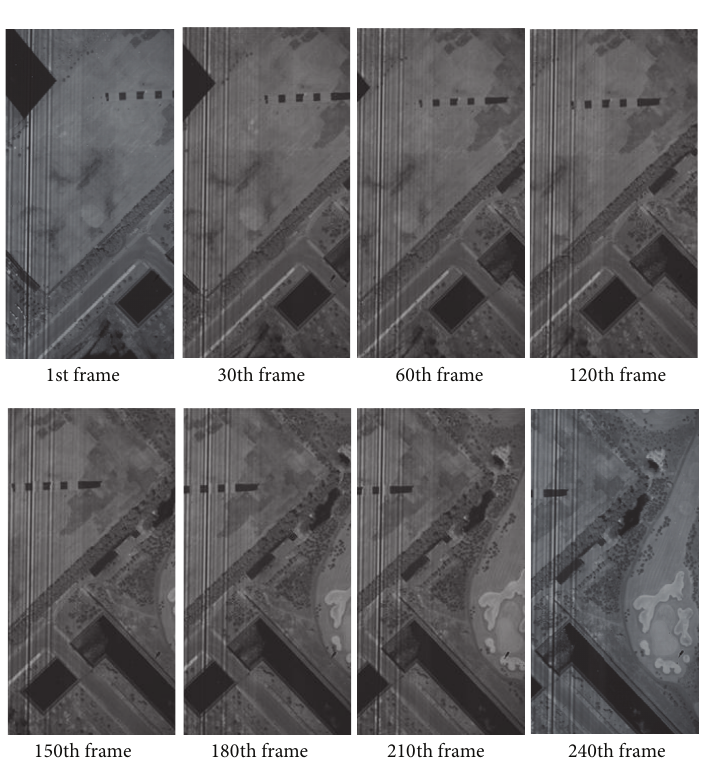
Figure 10: The interferogram with TSMFTIS using POS